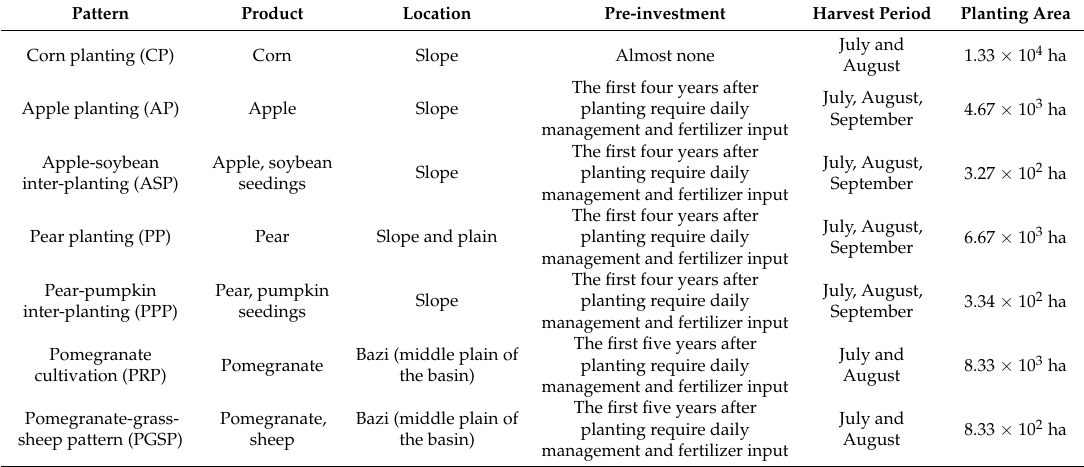
Table 1. Background information for the seven agroforestry planting patterns. Product Location Pre-investment Harvest Period Planting